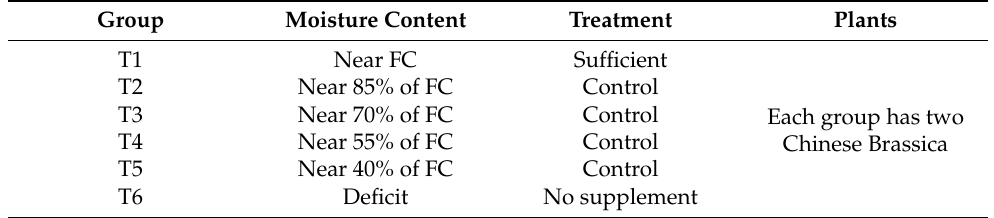
Table 1. Descriptions of group based on treatment.